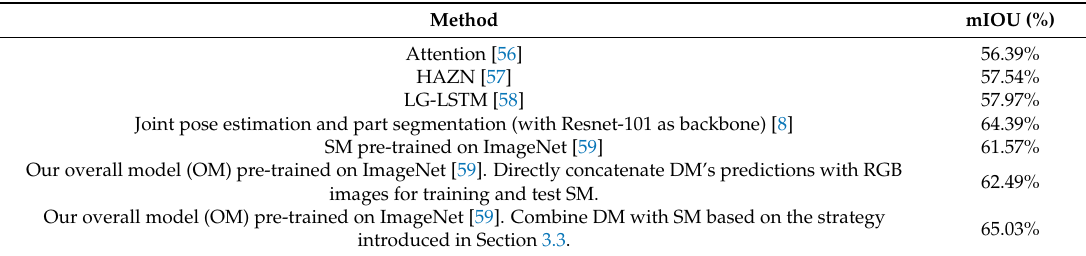
Table 1. Mean pixel IOU (mIOU) of human parsing on the PASCAL Person Part Dataset.